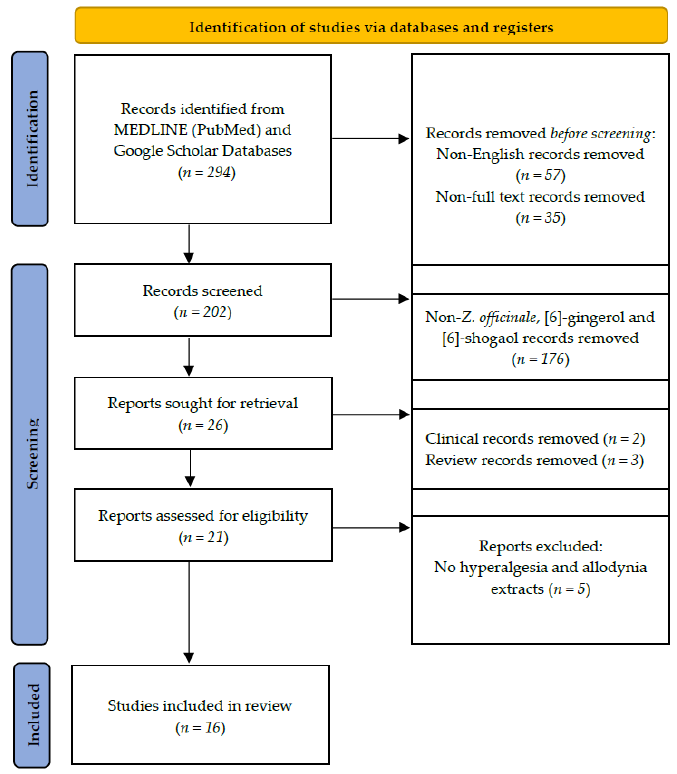
Figure 3. Flow chart of the article-inclusive protocol. Identification through searches of MEDLINE (PubMed) and Google Scholar yielded 294 articles, which were screened by abstract and full-text examinations. Finally, a total of 16 articles analyzing the effect of Z. officinale , [6]-gingerol and [6]- shogaol in hyperalgesia and allodynia in rodents were included in our